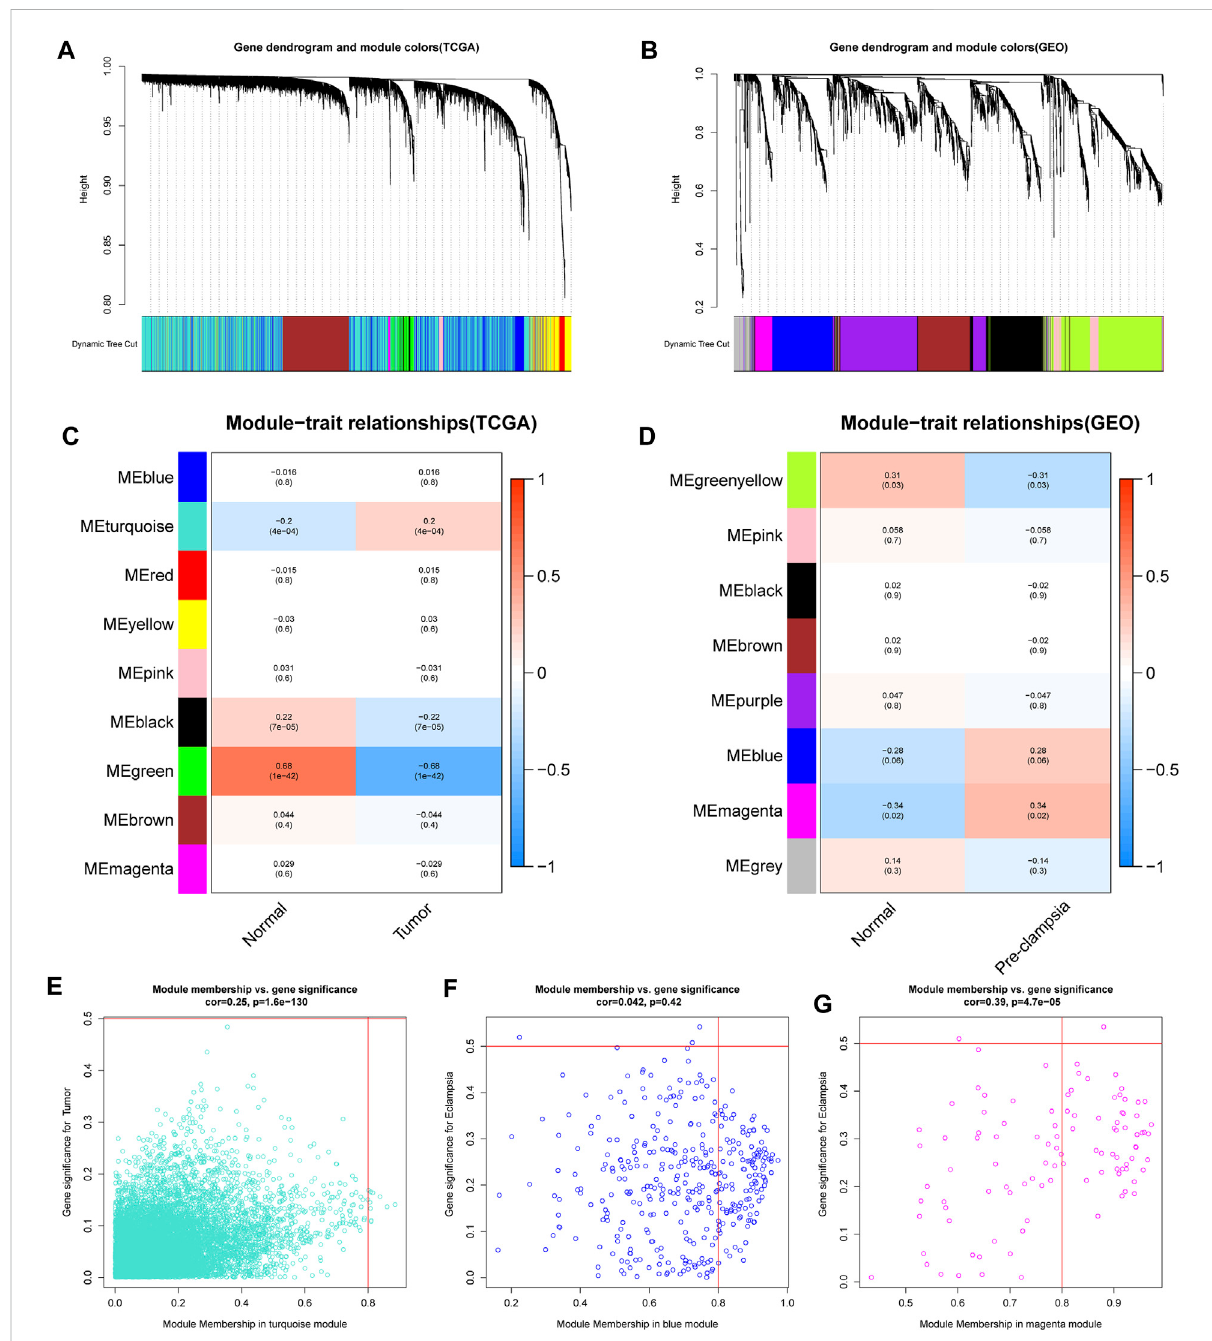
FIGURE 1 determination of the speci fi c modules in PE and CC by WGCNA. (A,B) Cluster plots of co-expressed genes in two diseases. (C,D) Heatmap of module – trait in two diseases. (E) The “ turquoise ” model was selected as cervical cancer-related module. (F,G) The “ blue ” and “ magenta ” modules were selected as pre-eclampsia-related